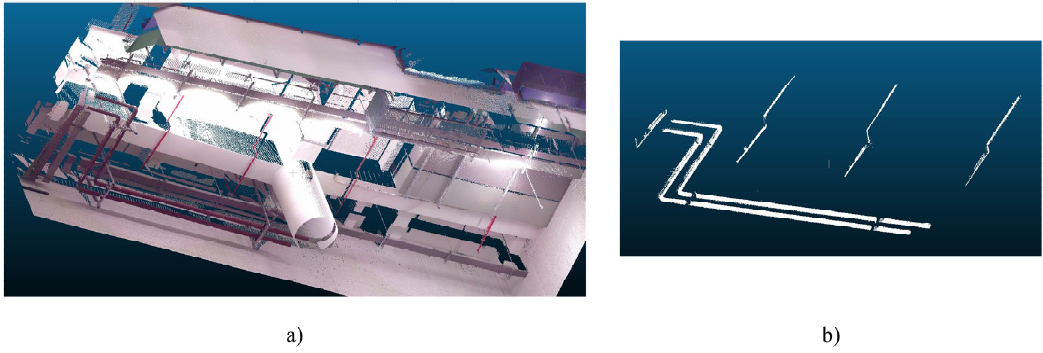
Figure 7. The point cloud dataset. ( a ) is the engineering scene dataset and ( b ) is showing extracted pipelines.